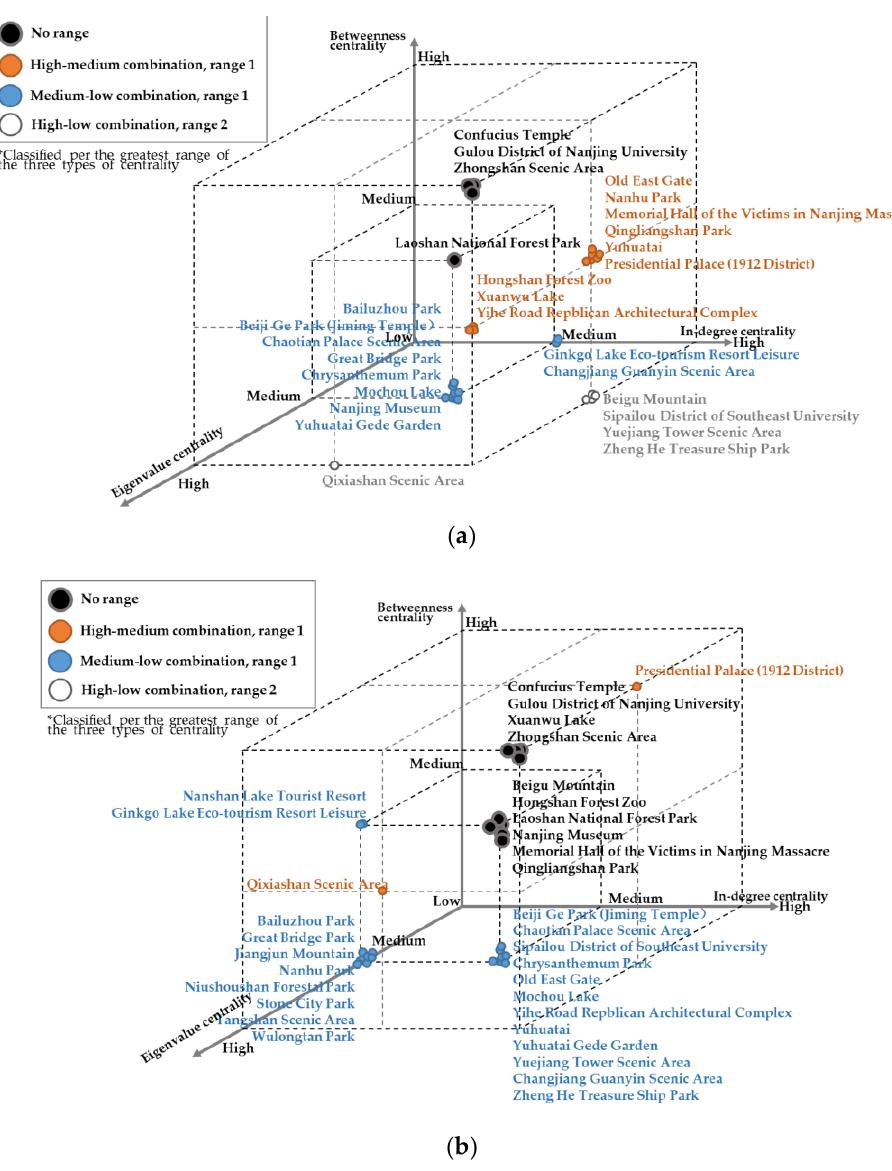
Figure 10. Comparison of the node status evaluation in resident networks and non-local tourist networks: ( a ) resident networks; ( b ) non-local tourist networks. networks: ( a ) resident networks; ( b ) non-local tourist